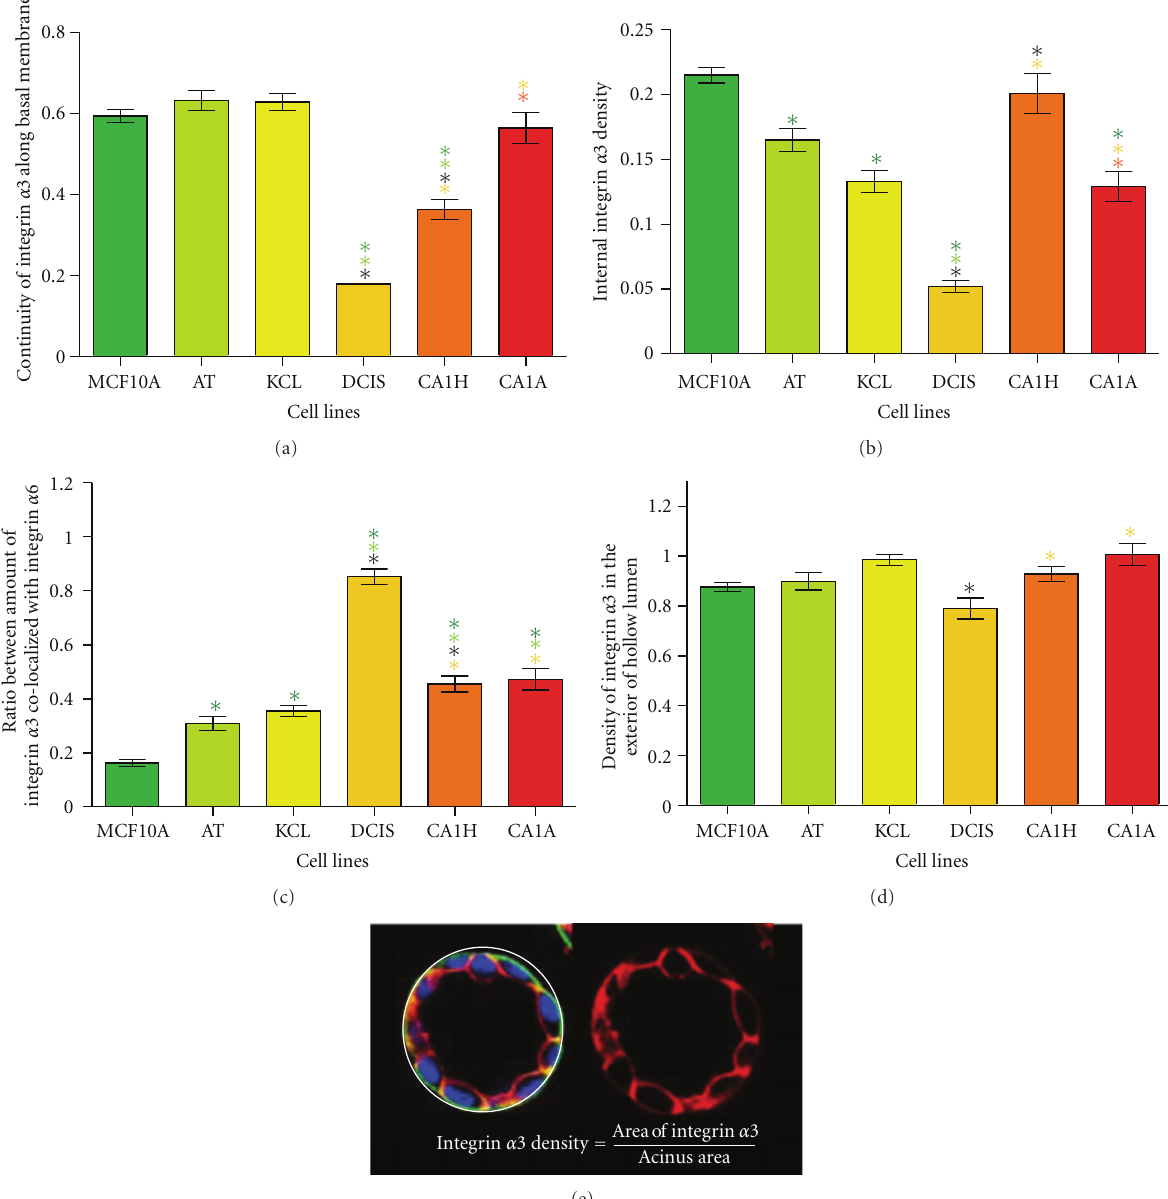
Figure 6: Features capturing the level of cell polarity based on the lateral membrane protein integrin α 3 density. (a) Shows the continuity of the integrin α 6 along the basal membrane, (b) shows the total integrin α 3 density that is computed as illustrated in (e) where the total amount of integrin α 3 within the acinar structure is divided by area of the acinar structure, (c) shows the ratio between the amount of integrin α 3 colocalized with integrin α 6 and the total integrin α 3 expression, and d shows the density of integrin α 3 in the exterior of the hollow lumen. Error bars correspond to the standard error of the means. Two-sided t -tests were performed and cell lines that exhibit statistically significance ( P < 0 . 05) are marked with asterisks ( ∗